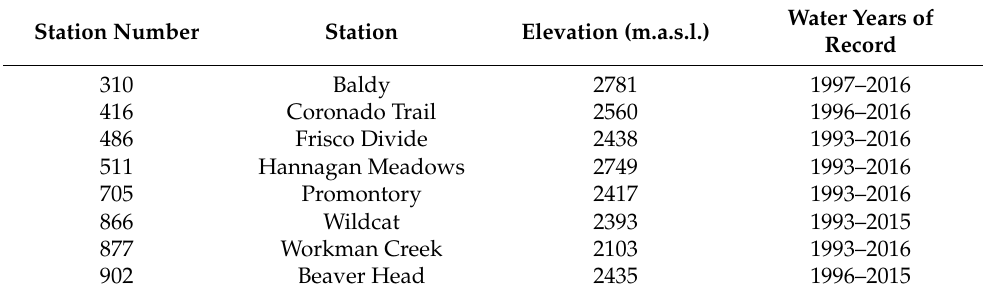
Table 2. SNOTEL climate stations used to develop and test the snow accumulation and melt model. Station Number